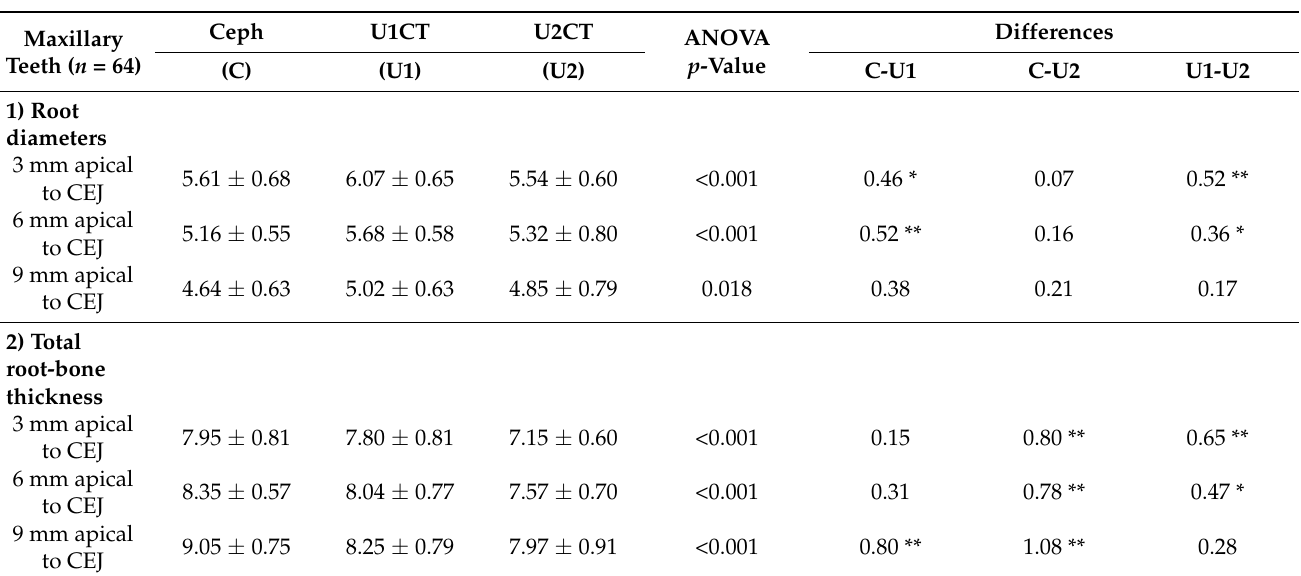
Table 3. Comparisons of root diameters and total root-bone thickness between Ceph, U1CT, and